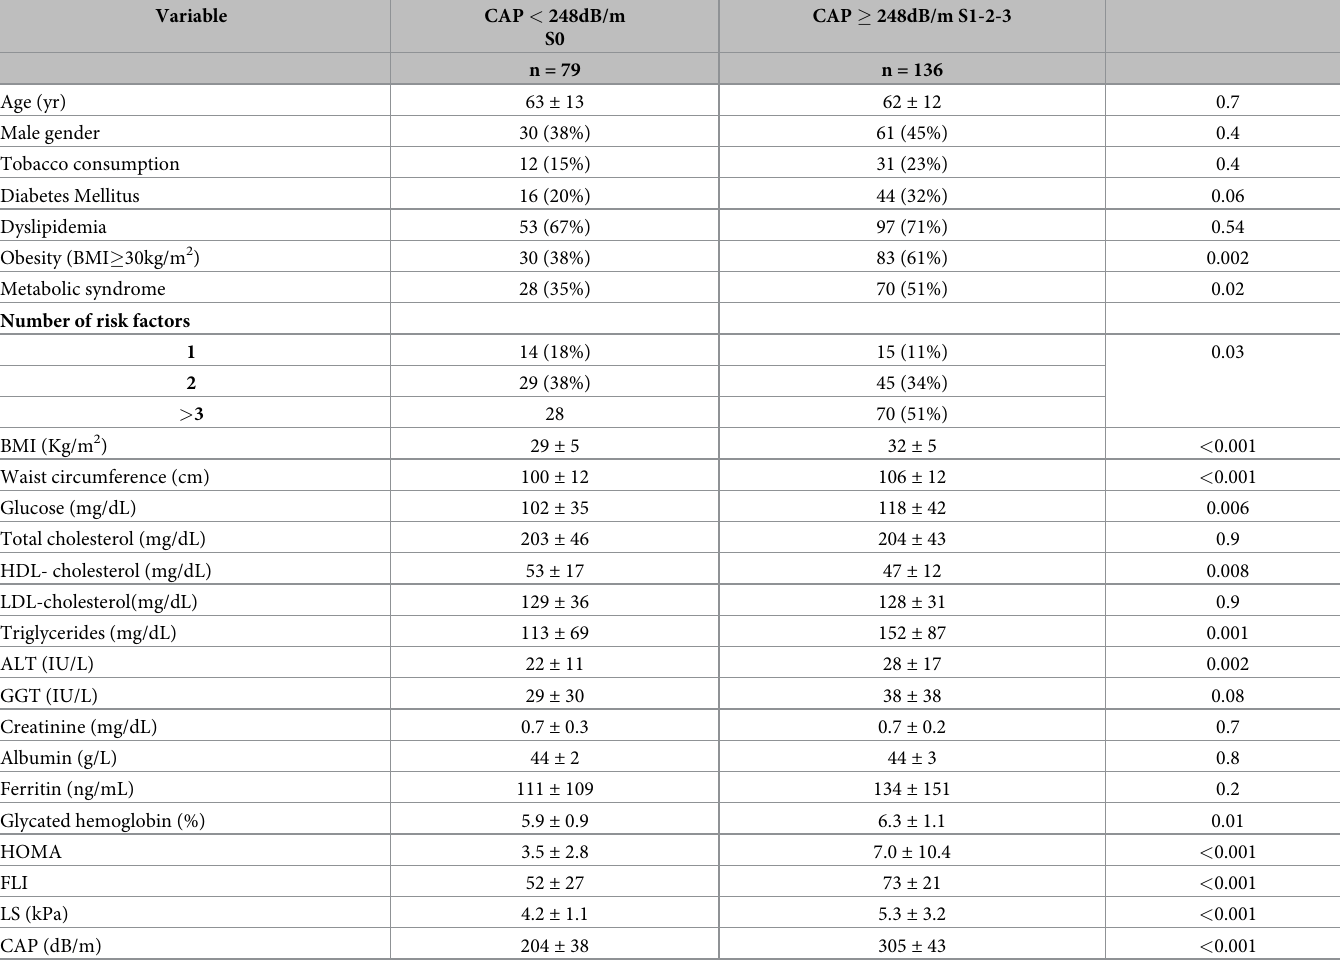
Table 3. Comparison of baseline characteristics of subjects with risk factors for NAFLD categorized according to the presence (S1-2-3) or absence (S0) of steatosis measured by CAP values.